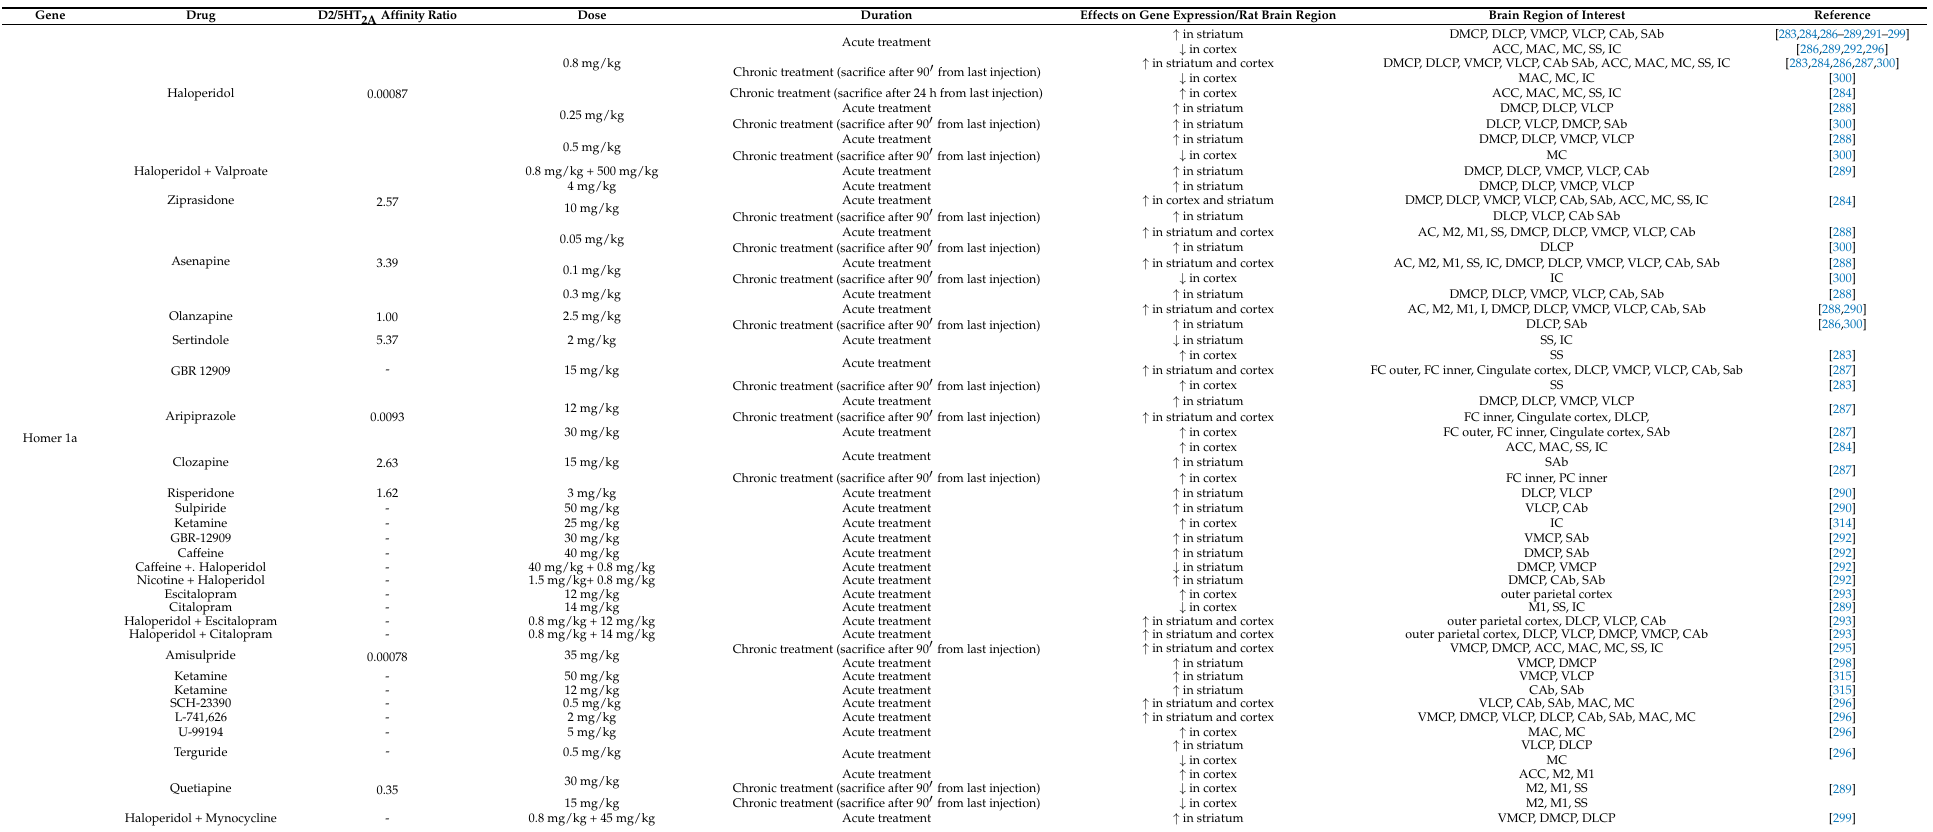
Table 1. Modulation of PSD proteins’ transcripts in different rat brain regions by antipsychotics and other psychotropic molecules related to their receptor profiles based on Sykes and co-authors’ studies [312,313]. ↑ = increased levels; ↓ = decreased levels; M1 = primary motor cortex; M2 = supplementary motor cortex; IC = insular cortex; DMCP = dorsomedial caudate-putame; DLCP = dorsolateral caudate-putament; VMCP = ventromedial caudate-putamen; VLCP = ventrolateral caudate-putamen; ACC = anterior cingulate cortex; MC = motor cortex; SS = somatosensory cortex; AC = Auditory Cortex; FC = frontal cortex; DG = dentate gyrus; SNc = substantia nigra pars compacta, VTA = ventral tegmental area; MAC = Medial Agranular Cortex; Cab = Core of the nucleus accumbens; Sab = shell of the nucleus accumbens 5HT = serotonin; PSD = postsynaptic density; IP3R = Inositol 1,4,5-trisphosphate receptor; Arc = activity-regulated cytoskeleton-associated protein; mGluR5 = metabotropic glutamate receptor 5; α CaMKII = alpha-Ca 2+ /calmodulin-dependent protein kinase-II; Shank = multiple ankyrin repeat domains; DAT = Dopamine Transporter; ERK = Extracellular signal-regulated